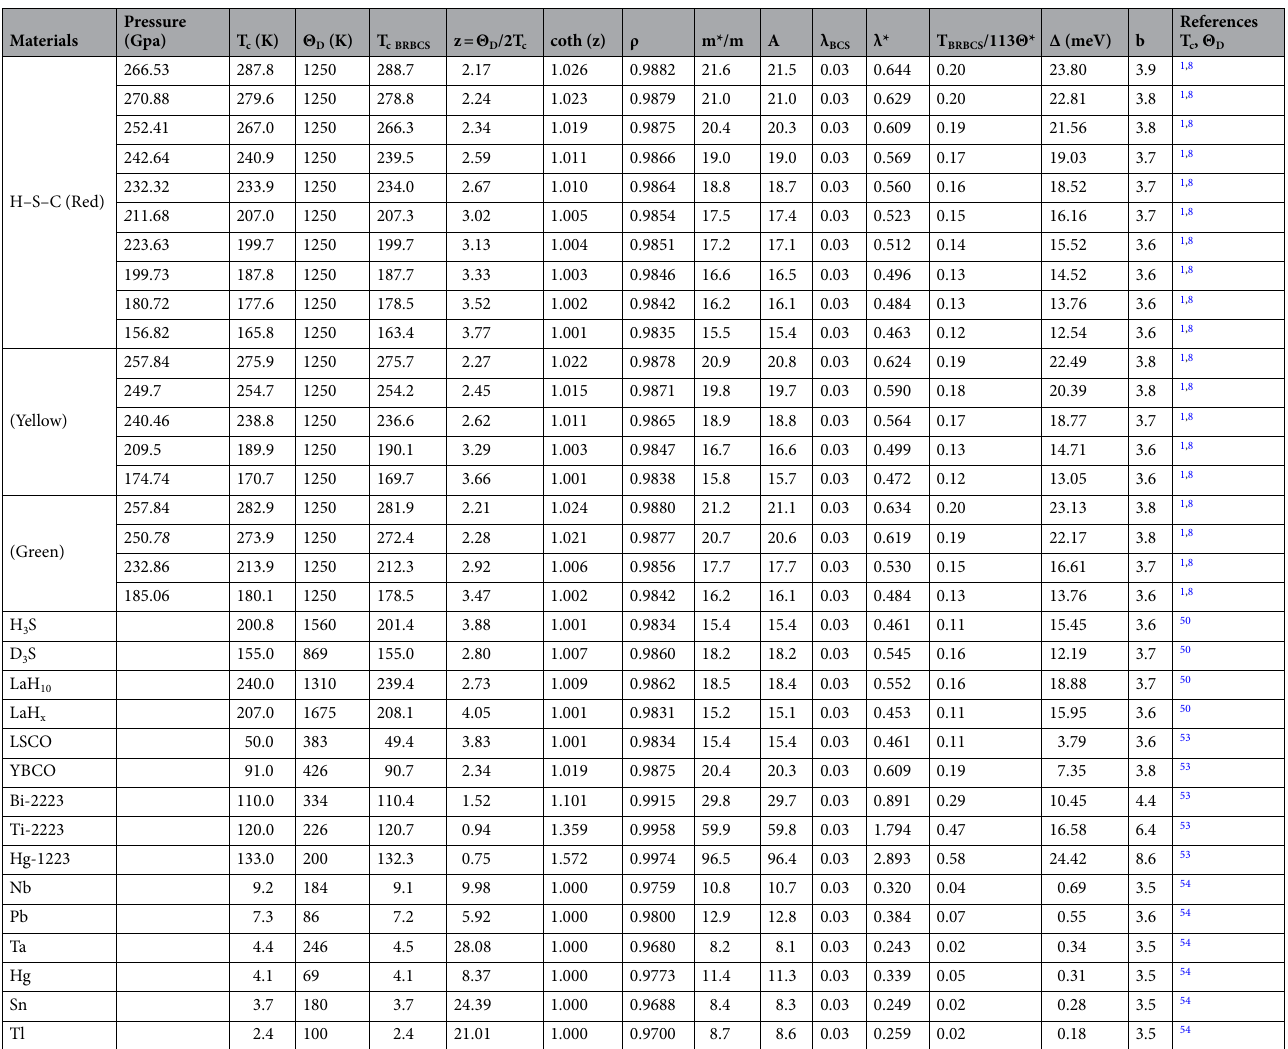
Table 1. When experimental data in Fig. 1 are confirmed by Eq. (6), the obtained parameters are evaluated by the following formulas; m * / m ≡ 1/(1 − ( U / U c ) 2 ) = 1/(1 − κ BR 2 ρ 4 ) ≈ 1/(1 − ρ 4 ) at κ BR ≈ 1 (≠